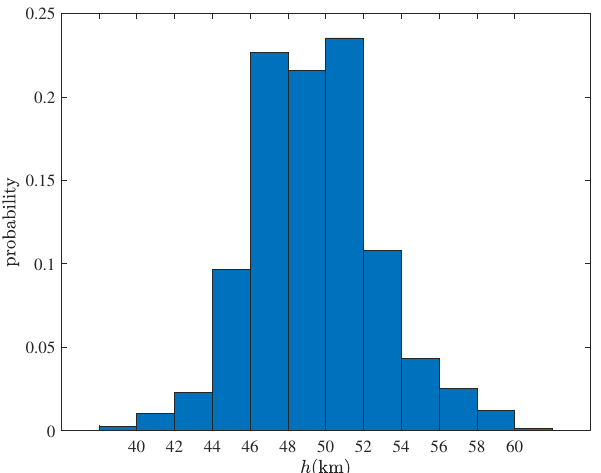
Figure 5. The histogram of altitude during the orbit maintenance. the x-axis represents the section of current altitude. the y-axis is for the proportion of each altitude section.